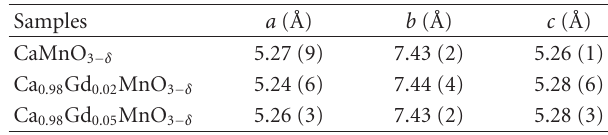
Table 1: Lattice parameters of the Ca 1 − x Gd x MnO 3 − δ (0.00, 0.02, and 0.05).